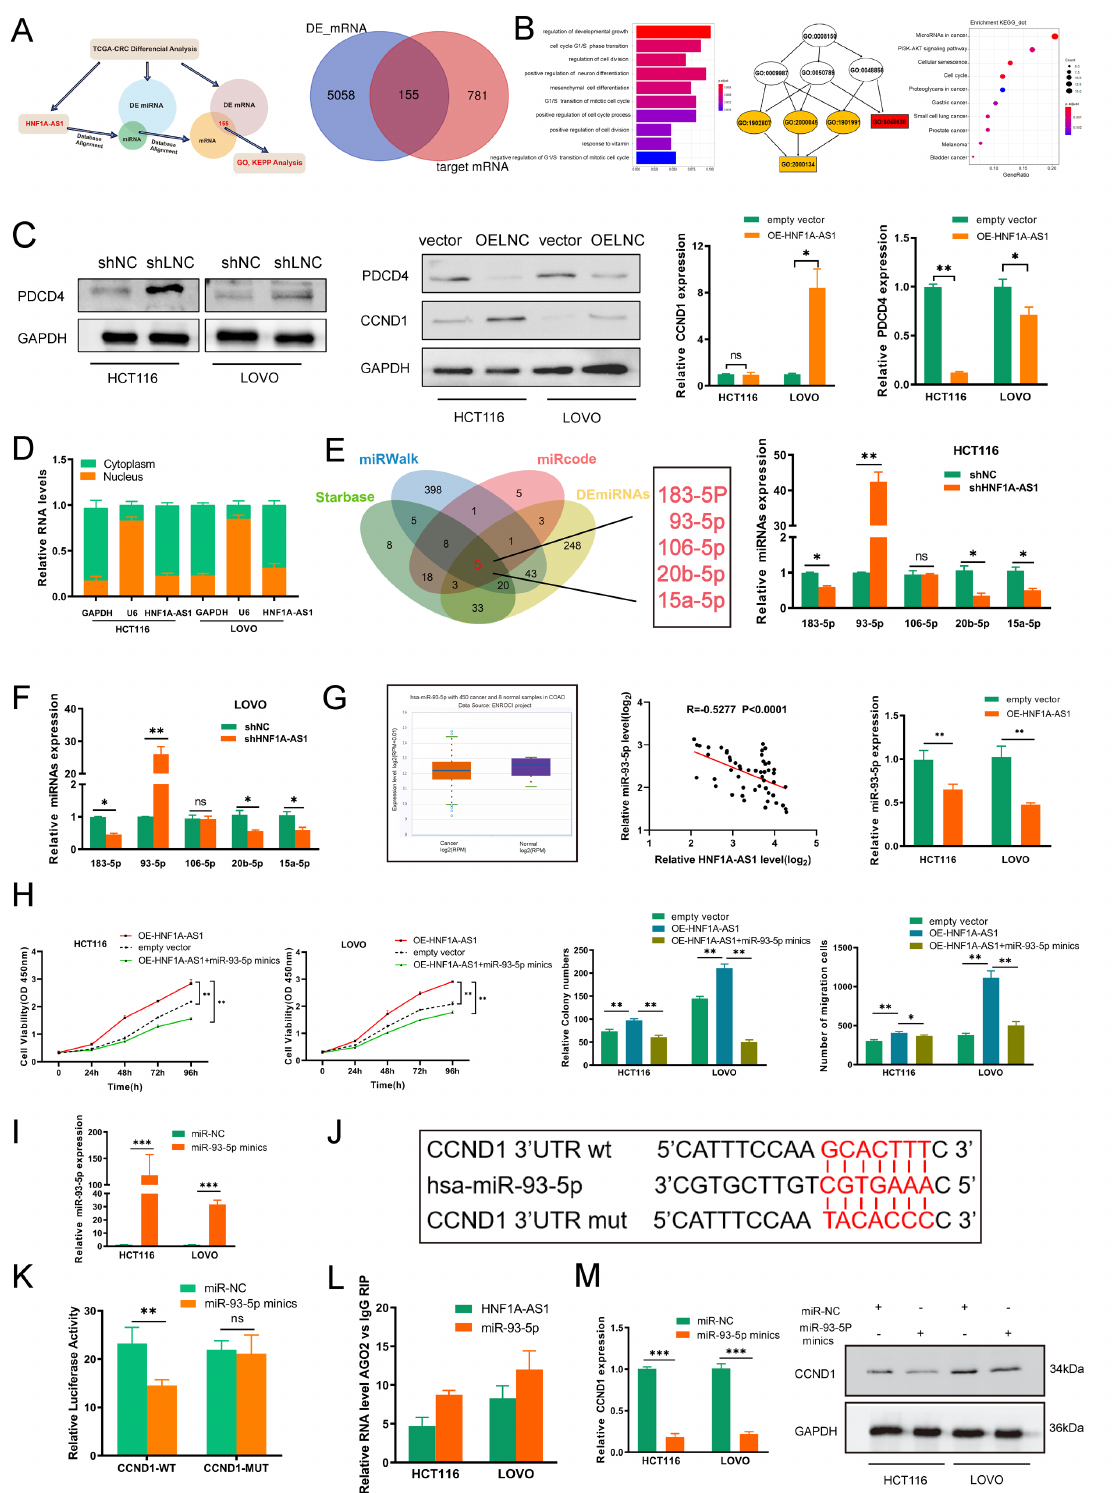
Figure 4. HNF1A-AS1 suppressed PDCD4 and sponged miR-93-5p to upregulate CCND1. ( A ) In total, 155 predicted downstream mRNAs were obtained by bioinformatics analysis. ( B ) The